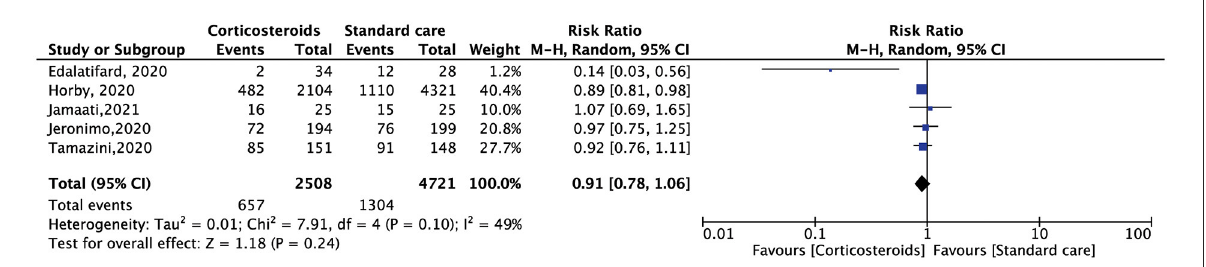
FIGURE3 Forest plot of comparison: 28-day mortality.